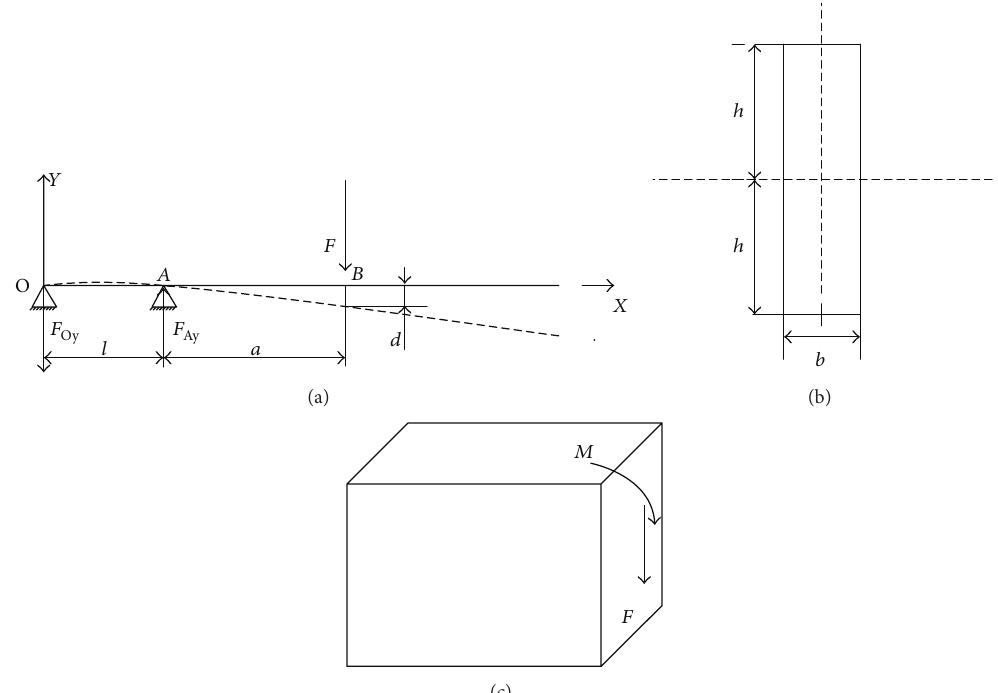
Figure 1: The simplified geometry model of test device to measure Young’s modulus of materials. (a) Schematic diagram of geometry; (b) schematic diagram of the cross section of the sample; (c) force analysis diagram of the cross section of the